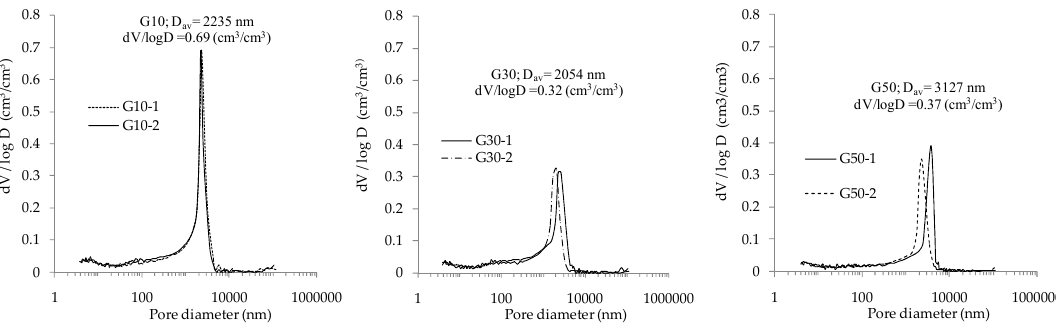
Figure 5. Pore size distribution of FA-GGBFS blended geopolymers mortars by MIP. For geopolymer mortar samples G50-1 and G50-2 the results cumulative pore volume have shown that the total porosity of those materials reached the values of 0.145 and 0.144 cm 3 /cm 3 , which was 37% lower than for G10 mortars, which presented 0.227 and 0.237 cm 3 /cm 3 . The addition of higher content of GGBFS resulted in lower porosity and a denser structure.